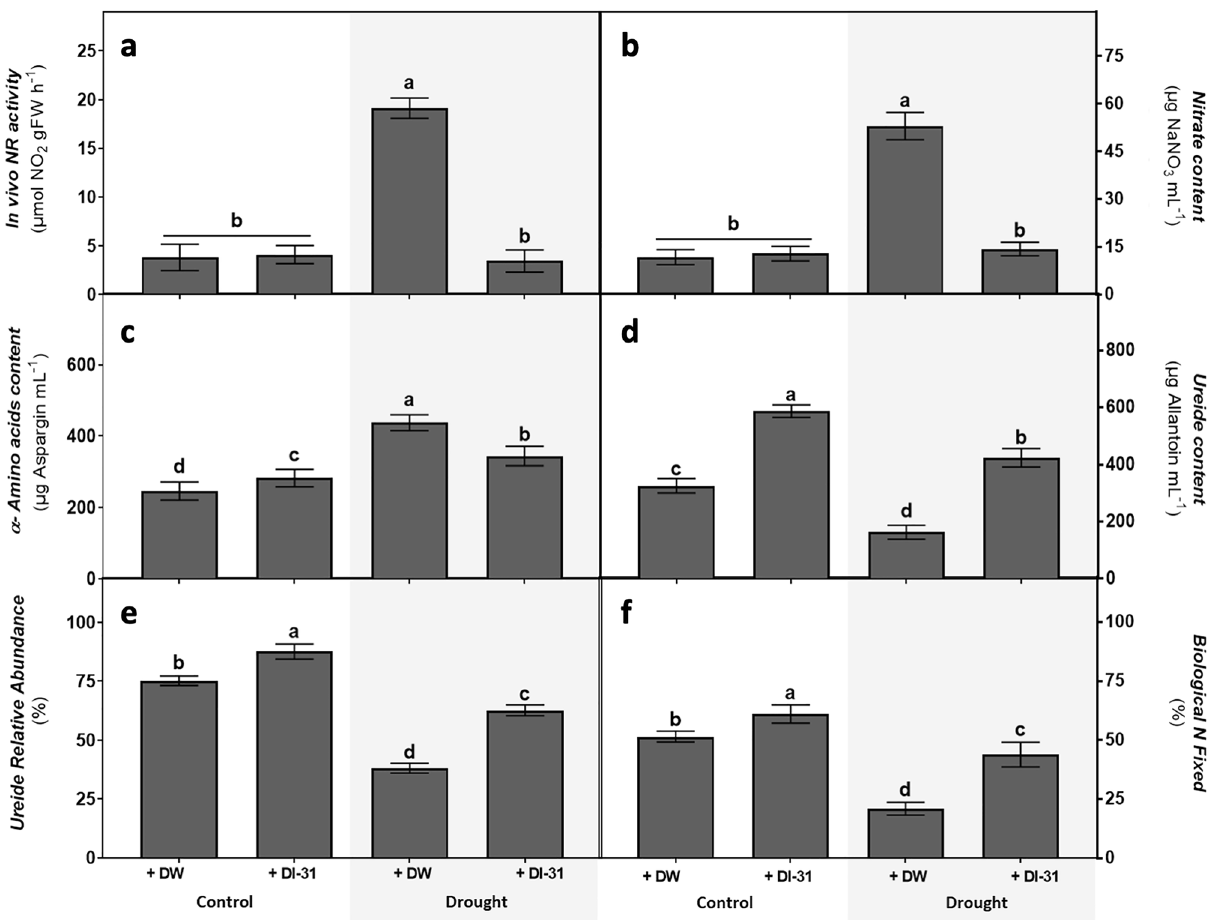
Figure 5. Effect of distilled water (DW) and DI-31 (2.23 µM) foliar applications in soybean N homeostasis. Parameters such as ( a ) in vivo nitrate reductase (NR) activity, ( b ) nitrate content, ( c ) α-amino acids content, ( d ) ureide content, ( e ) ureide relative abundance and ( f ) biological N fixed were measured in cv Munasqa plants submitted to well-watered (Ψs = − 0.05 MPa) and drought (Ψs = − 0.65 MPa) conditions for ten days. Data are presented in means ± s.e.m of two independent experiments (n = 120). Different letters indicate significant differences ( P ≤ 0.05) ANOVA with post hoc contrasts by Tukey’s